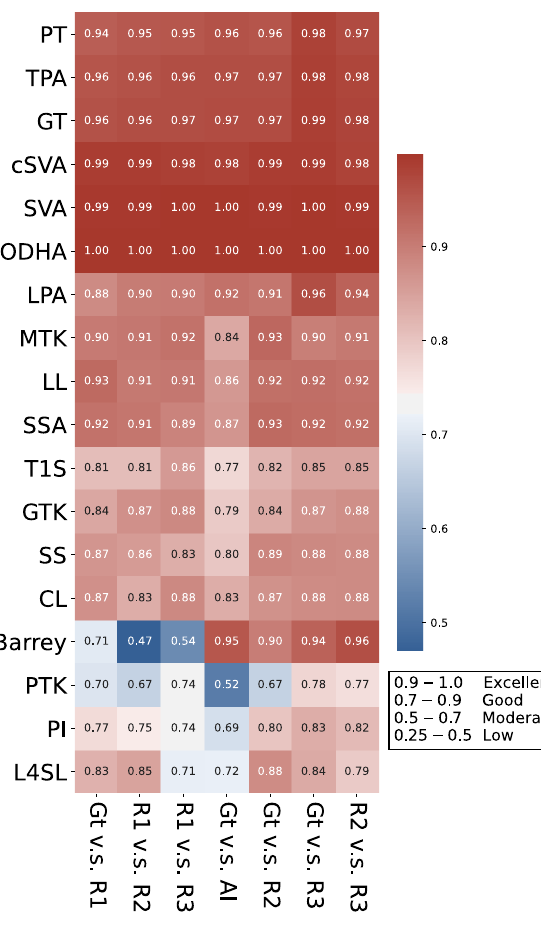
Figure 7. Heatmap of intraclass correlation coefficient (ICC) between human observers and the deep learning model. The interobserver reliability of three human observers (R1: junior resident; R2: spine fellow; R3: senior surgeon), the deep learning model (AI), and the ground truth values (Gt) was compared using the intraclass correlation coefficient (ICC). The ICC heatmap presented a data matrix, where colouring offers an overview of the numeric ICC differences for each radiographic parameter. Hierarchical cluster analysis was used to build a hierarchy of the ICC heatmap clusters. The deep learning model (AI) was capable of matching the reliability of human observers in 15/18 of the